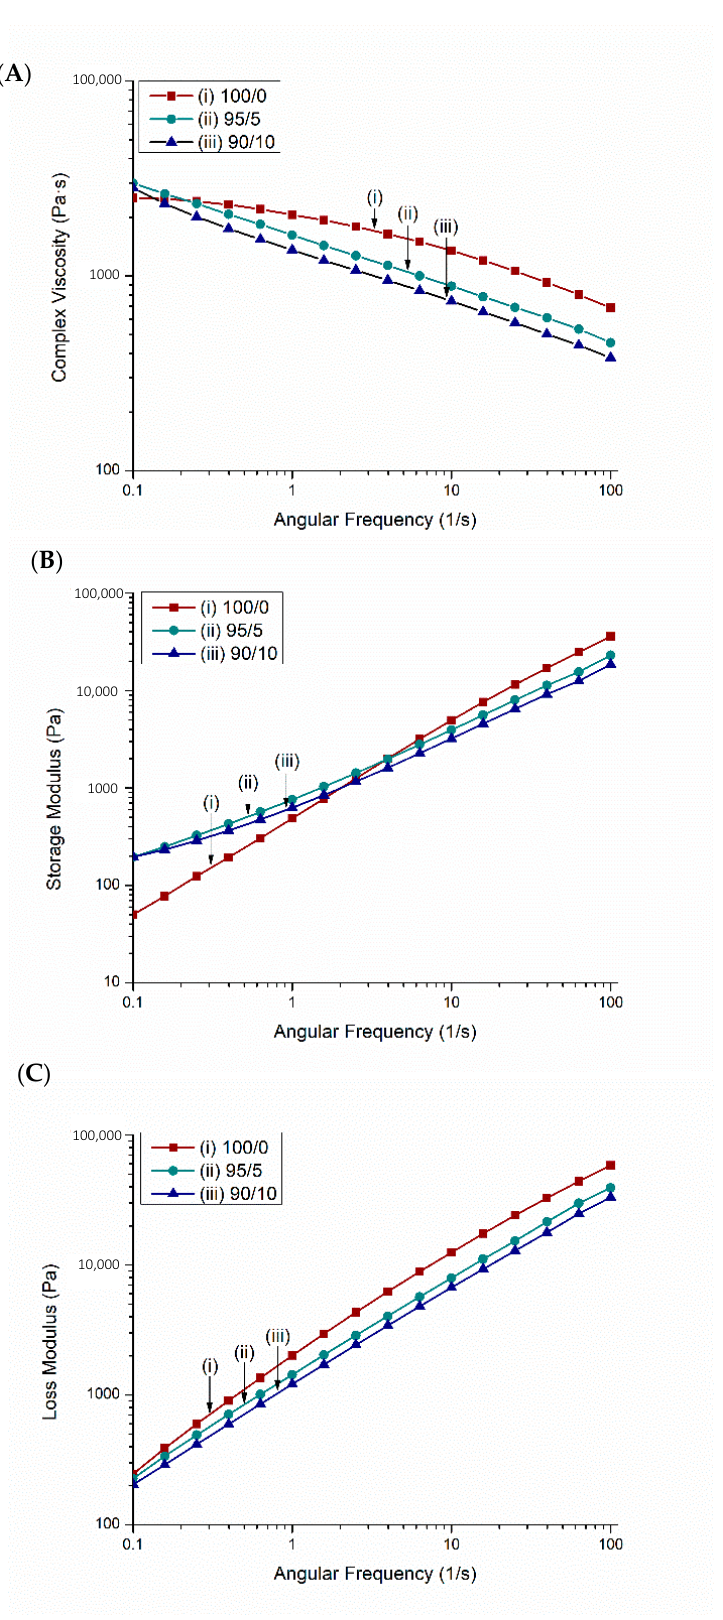
Figure 5. Rheological analysis of composites: ( A ) complex viscosity ( η ), ( B ) storage modulus (G’), and ( C ) loss modulus (G’’) for injection molded samples of the PTT blend and Miscanthus BC composites. See Table 2 for nomenclature.